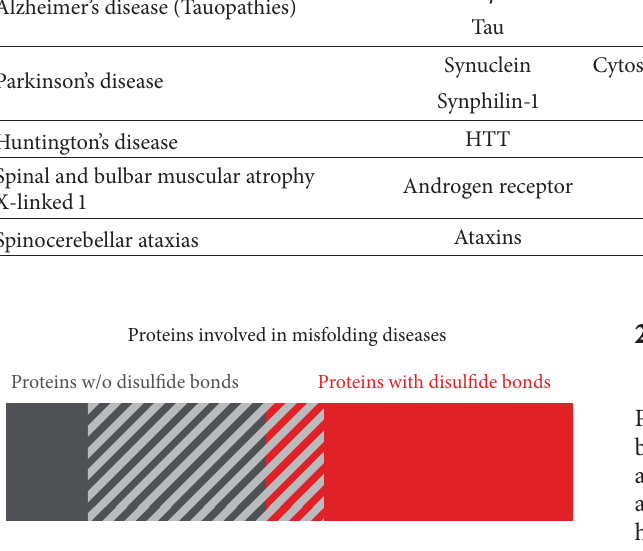
Figure1: Disulfidepresence (red)inproteinsinvolved inmisfolding diseases (solid) and in neurodegenerative misfolding diseases (pat-